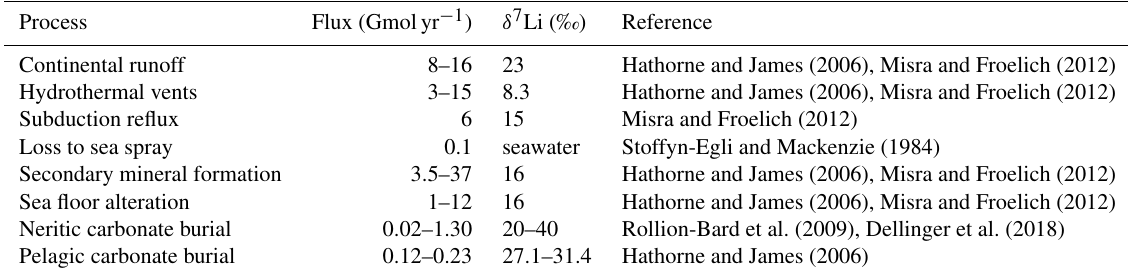
Table 3. Estimates of pre-industrial Li fluxes between surface reservoirs and their isotopic composition. In the calculation of Li burial with calcium carbonate, the estimates of calcium burial in Table 4 were used, assuming a 50 : 50 split in calcium carbonate burial fluxes between neritic and pelagic environments (Milliman, 1993).